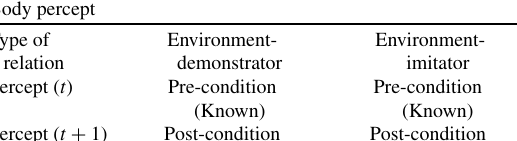
Table 1 The difference between the body schema and body percept when observing and performing an action Feature Observing Performing Body percept Type of Environment- Environment-